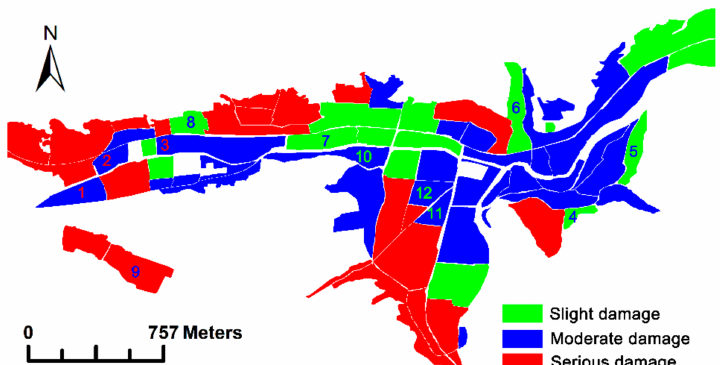
Figure 10. Building earthquake damage assessment results for the Yushu urban region at the city block scale. The blocks numbered 1–12 are misclassified, and the color of the numbers denotes the color of the correct damage level.